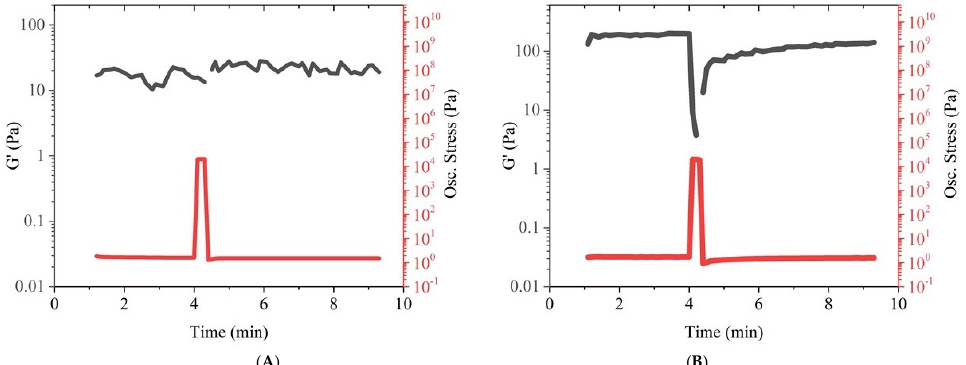
Figure 3. Re covery behaviour of PCL ( A ) and PCL-CCG 0.5 ( B ) under stress. Figure 3. Recovery behaviour of PCL ( A ) and PCL-CCG 0.5 ( B ) under